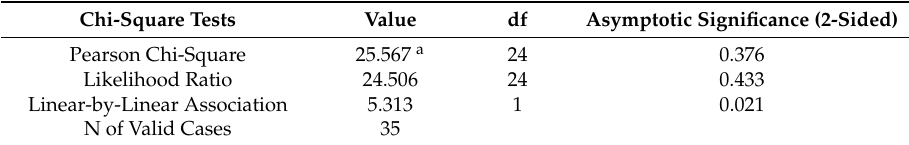
Table A9. Chi-square tests: Game * Education.